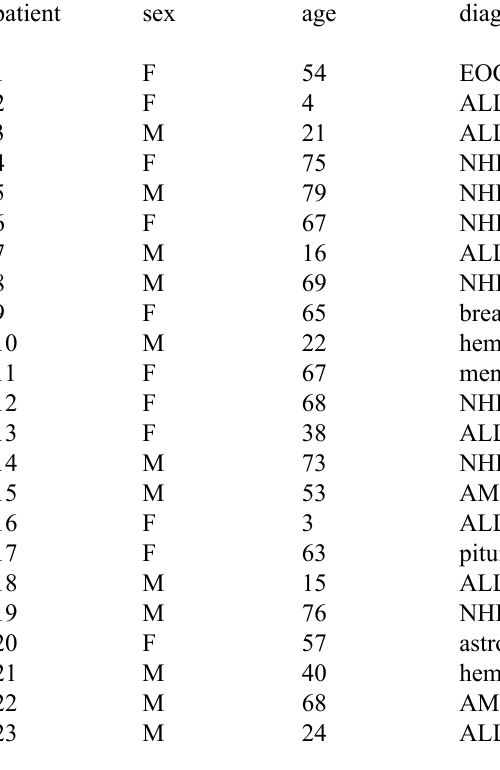
Table 2. CSF neopterin concentrations in patients without infectious, inflammatory or neoplastic disorder of CNS (control